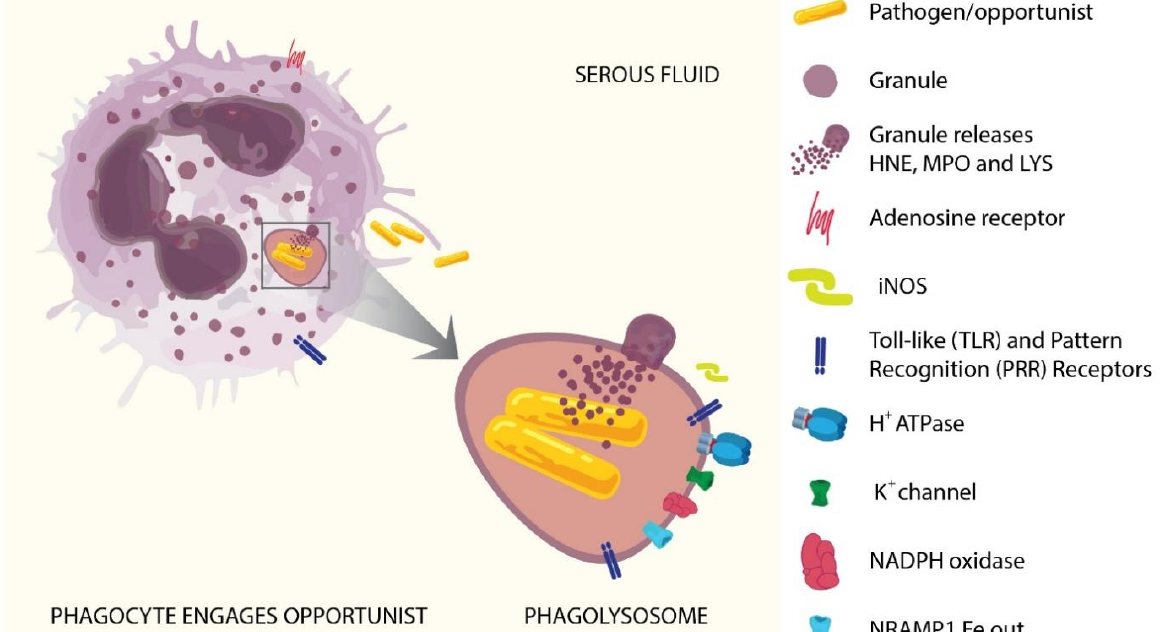
Figure 3. Neutrophil response to a potential pathogen (e.g., Enterobacteriaceae, or Pseudomonas aeruginosa ). Upon contact with a pathogen, engulfment at the cell surface results in formation of a pre-lysosome to which function is added by fusion with various granules. Cation inward transport is activated, supplying K + to exchange lytic enzymes occupying heparin sites on granules, and to exchange for H + at later stages for maturation. At the membrane interface, transport is energized by H + -ATPase, which promotes pH reduction. In parallel, granules fuse and release lytic enzymes in concentrated form at the pathogen surface where they can cause local pore formation (resulting in loss of pH control). Up-regulation of NADPH oxidase supports oxidative burst via H 2 O 2 production. Cl - ion influxed with K + is oxidized to hypochlorite (HOCl). While oxidative burst is considered to be an antibacterial process, chlorination is also a means of inactivating human antimicrobial enzymes [86,89], thus detoxifying the lysosome once the pathogen is killed. Abbreviations: HNE = human neutrophil elastase; MPO = myeloperoxidase; LYS = lysozyme; iNOS = inducible nitric oxide synthase; ATPase = H + pump driven by ATP; NADPH = reduced (hydrogen form) of nicotinamide adenine dinucleotide phosphate; NRAMP1 Fe out = natural resistance-associated macrophage protein 1.